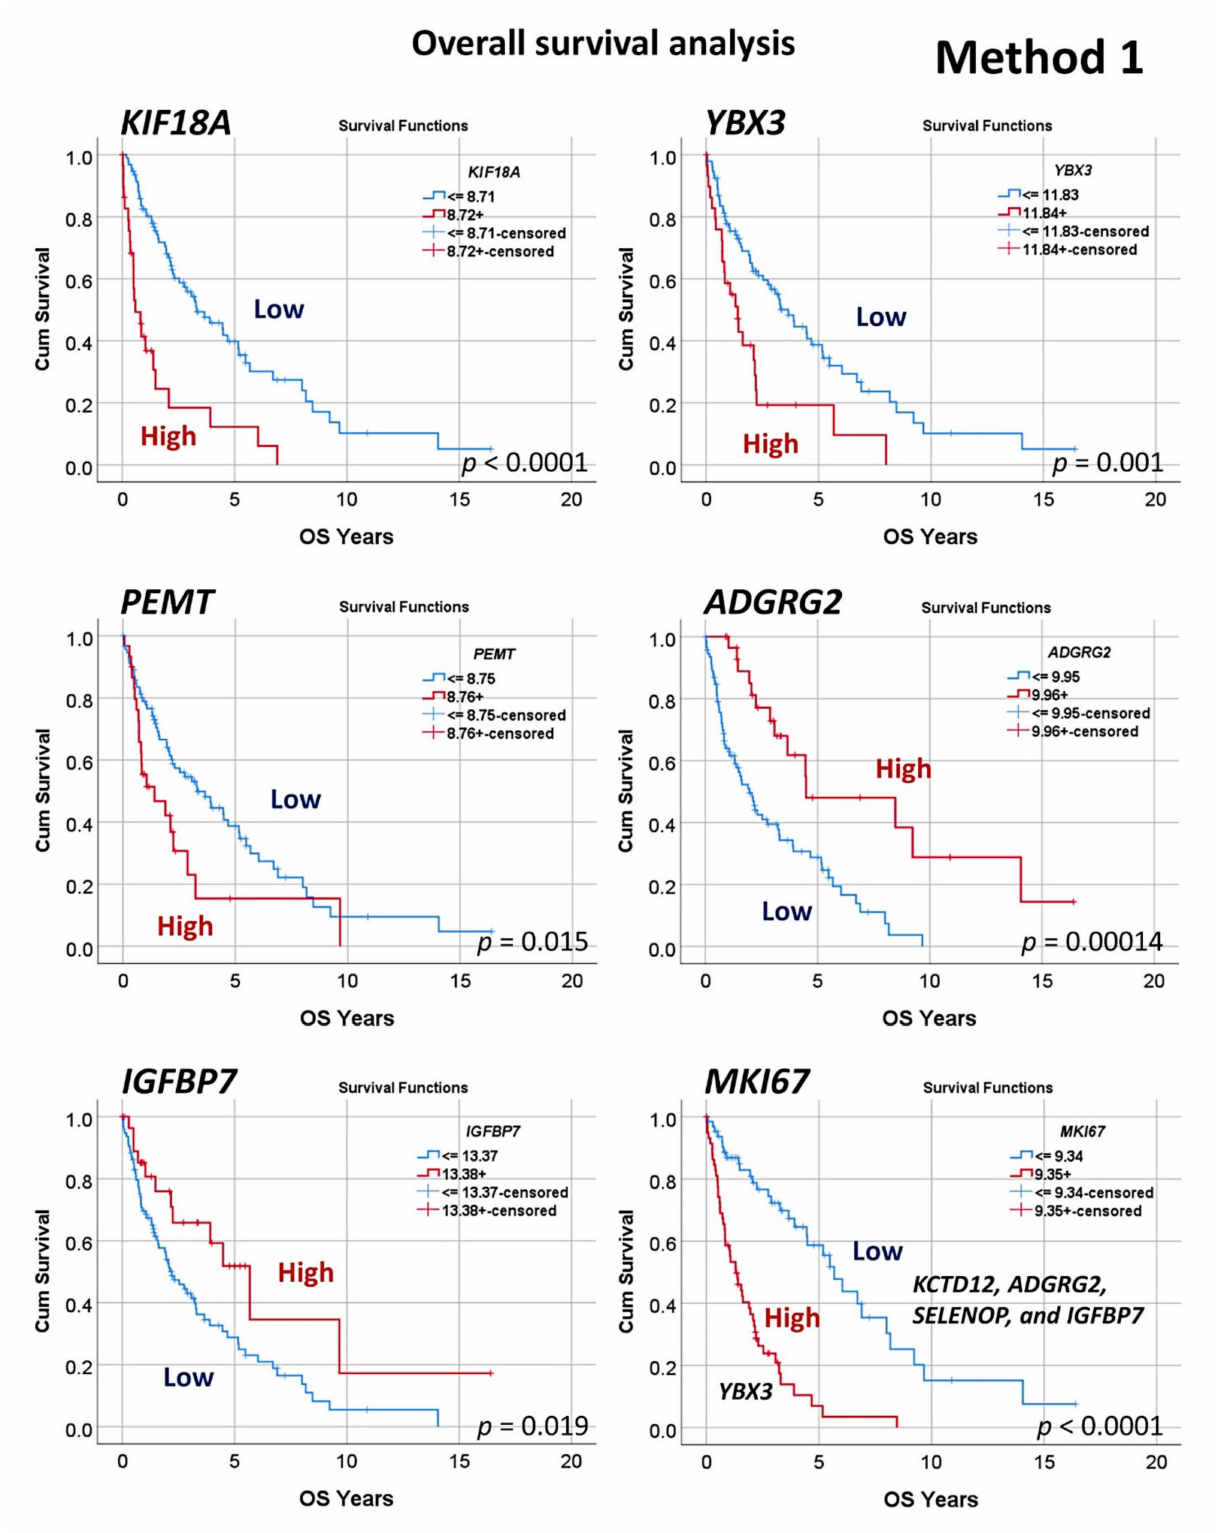
Figure 7. Overall survival analysis (Method 1 continuation). Because of the neural network analysis and dimensional reduction (Figures 4 and 5), a final set of 10 genes with overall survival relationship was highlighted. These genes not only correlated with the clinical outcome but also with the proliferation index, as expressed by MKI67 . Of note, ki67 is a marker routinely used for prediction in mantle cell lymphoma, and the most relevant marker of the LLMPP MCL35 proliferation